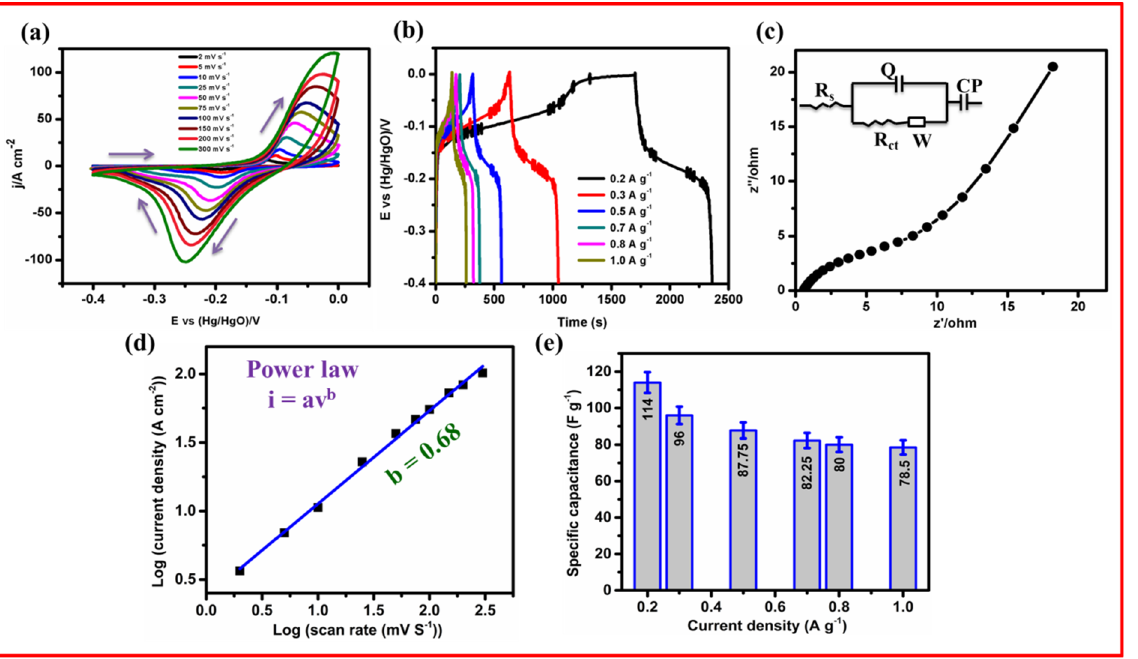
Figure 4. Ce(HPO 4 ) 2 .xH 2 O/NF in a three-electrode set-up: ( a ) CVs with different scan rates between 2 and 300 mV s − 1 ; ( b ) GCD profiles with different densities of current; ( c ) EIS plot; ( d ) power law diagram; and ( e ) different current density versus specific capacitance graph.